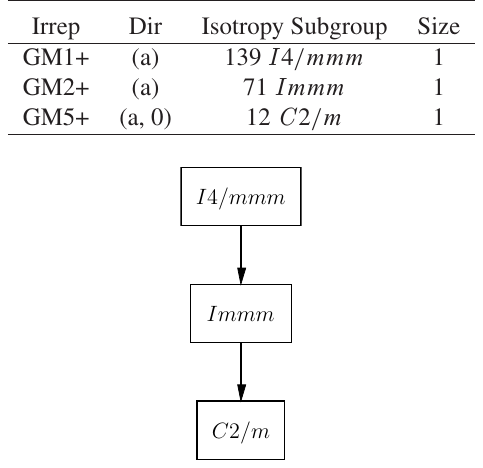
Table 6. Irreps compatible with the symmetry break I 4 /mmm −→ C 2 /m ( − b − c , a , c ; 000) obtained with the program COPL [15].